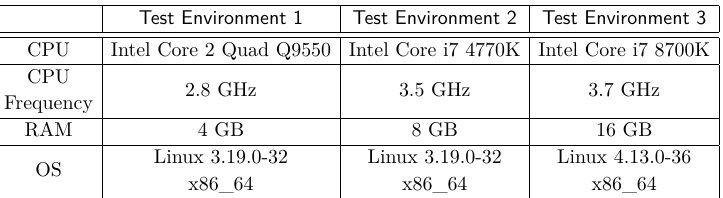
Table 2: Environments used for